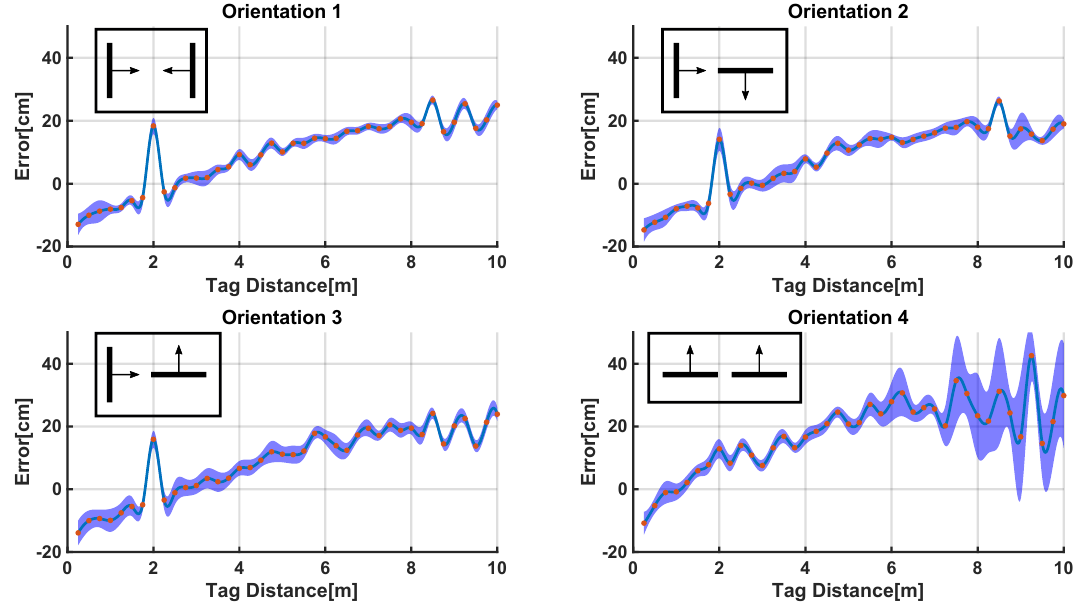
Figure 9. Error affecting the estimates of the distance between the anchor unit and the radio tag for different orientations of the antennas. The error is higher for orientation 4 where both the antenna of the anchor unit and the antenna of the radio tag are aligned. The red dots represent the tested data points. The blue areas represent the variance of the